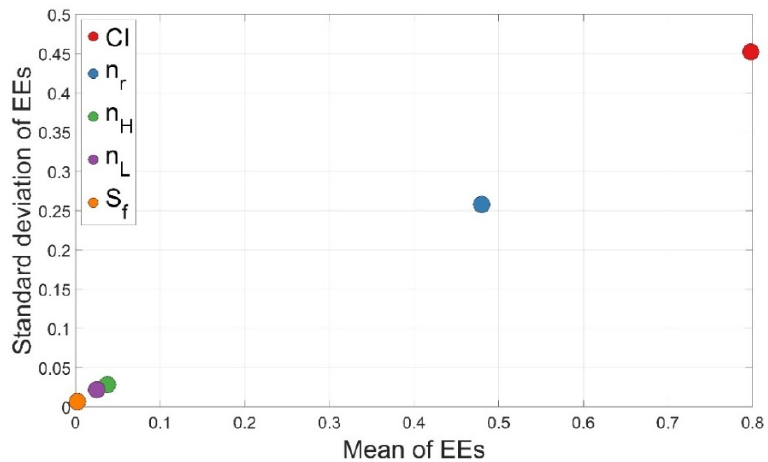
Figure 10. Sensitivity analysis